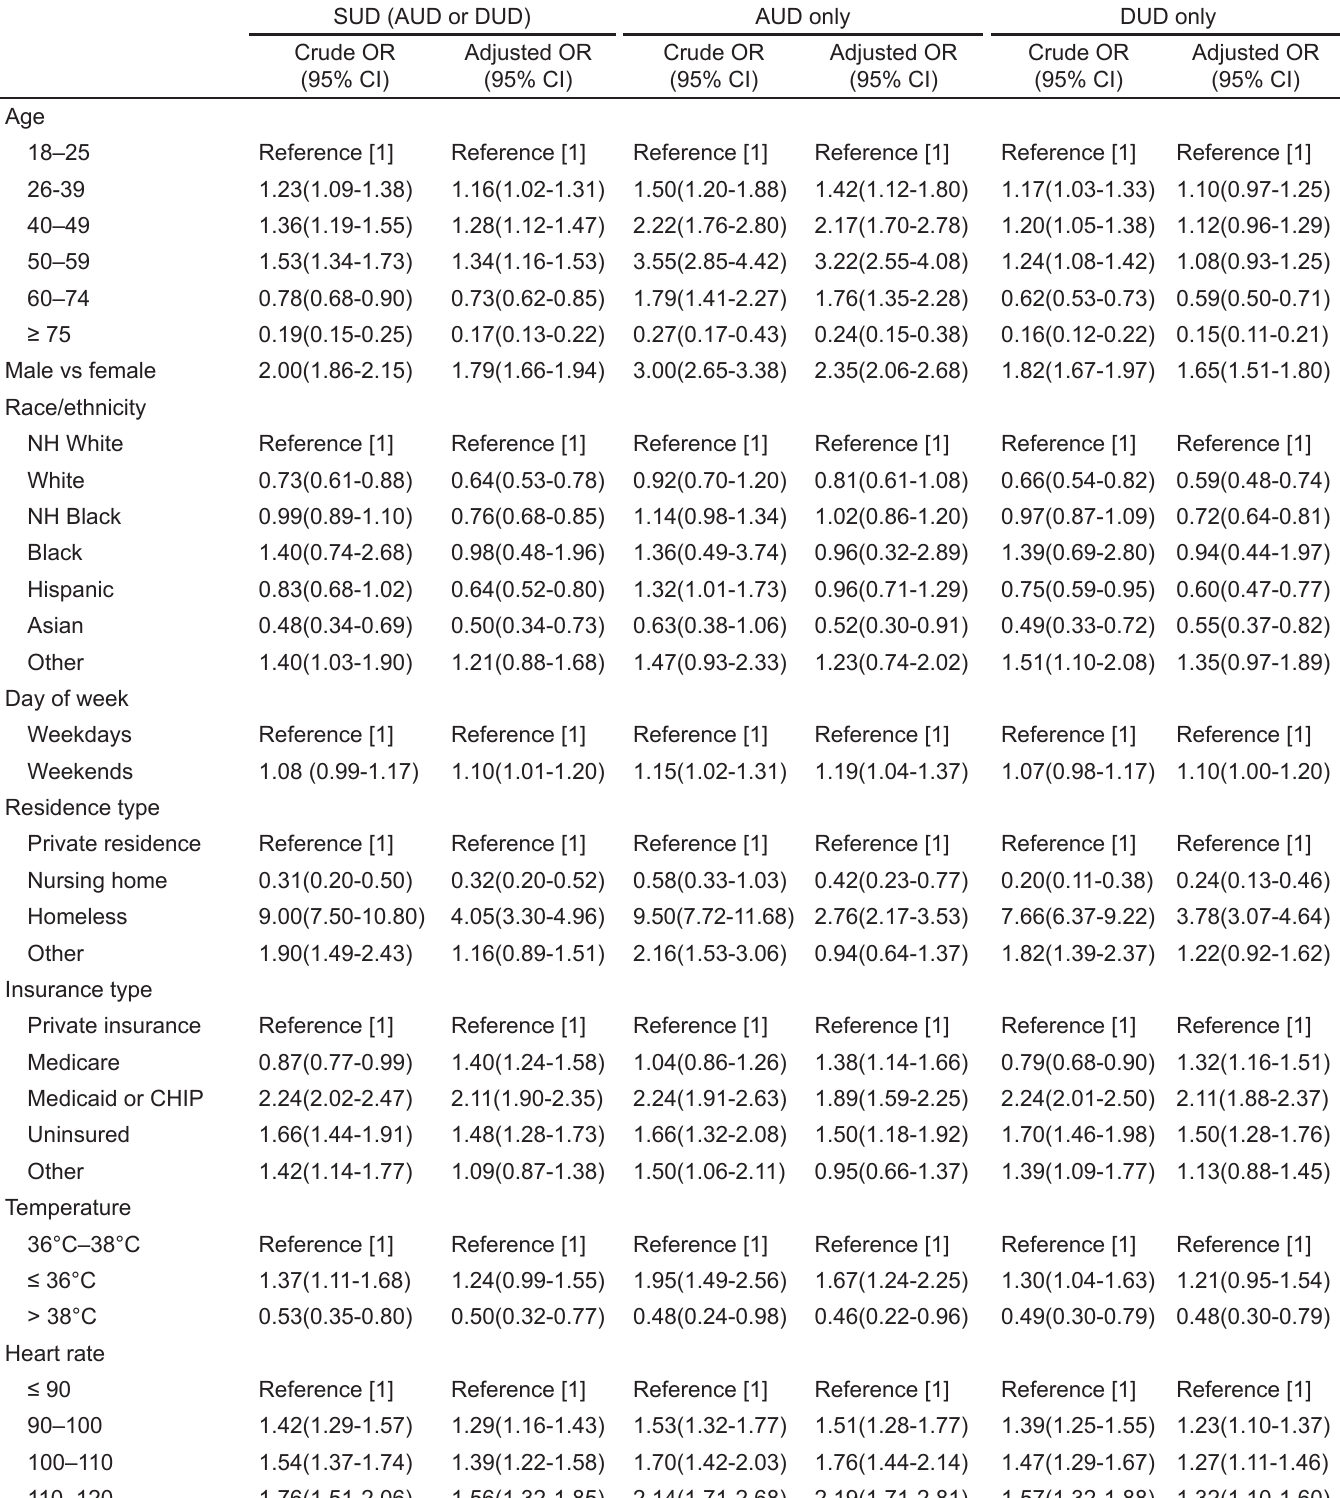
Table 3. Association between alcohol/substance use disorder status in emergency department patients and their visit characteristics (*NHAMCS